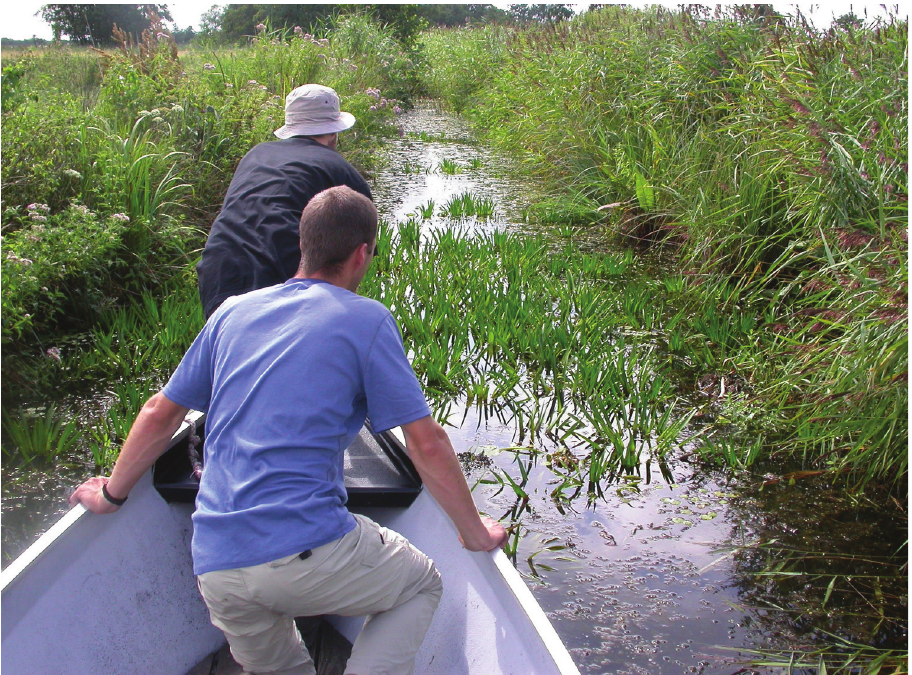
Habitat Lycaena dispar , Netherlands. Photo: Jaap